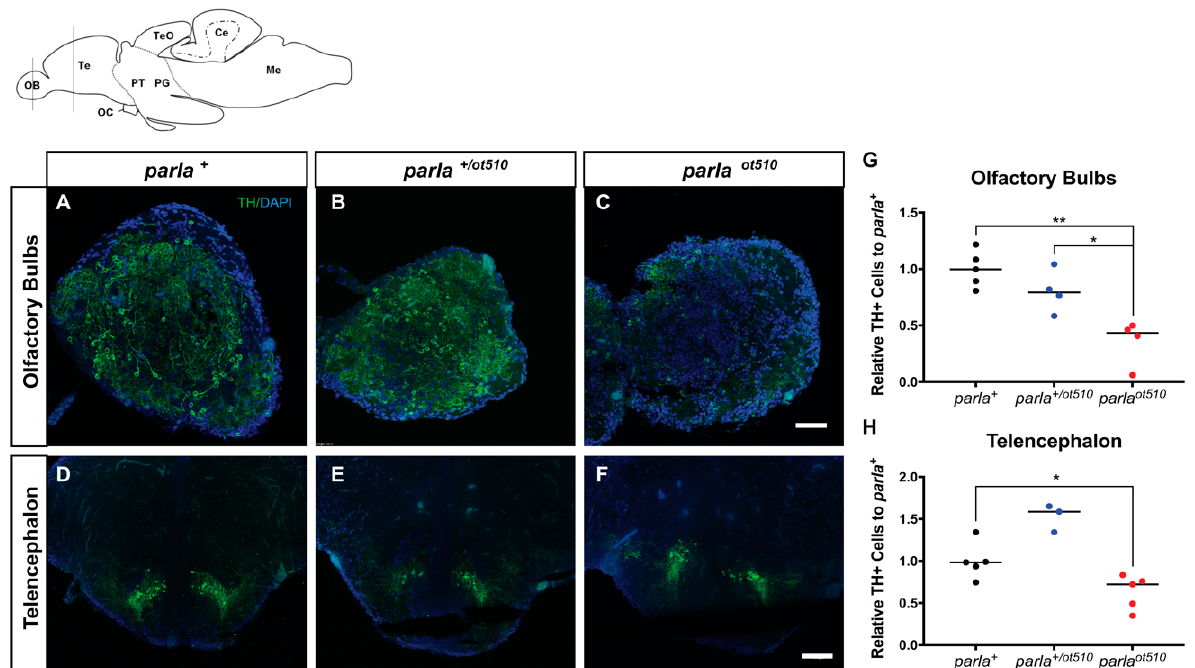
Figure 3. Impacts of parla loss-of-function on dopaminergic (DA) neuron cell number in the telencephalon and olfactory bulbs of adult zebrafish. Schematic representation of olfactory bulb (OB) and telencephalon sections depicted in the top left panel. ( A – F ) Transverse cryosections showing immunofluorescence of TH+ (Green) and DAPI stained (Blue) cells in dissected OB ( A – C ) and telencephalon ( D – F ) of adult zebrafish. Scale bar: 50 µm . ( G , H ) Quantification of the number of cells expressing TH. WT fish are represented by parl + , homozygous mutants by parla ot510 , and heterozygous mutants by parl +/ot510 ( n = 5 for parla + , n = 4–5 for parla ot510 and n = 3–4 for parla +/ot510 adult zebrafish). Bars represent the Median. * ( p < 0.05), ** ( p < 0.01).